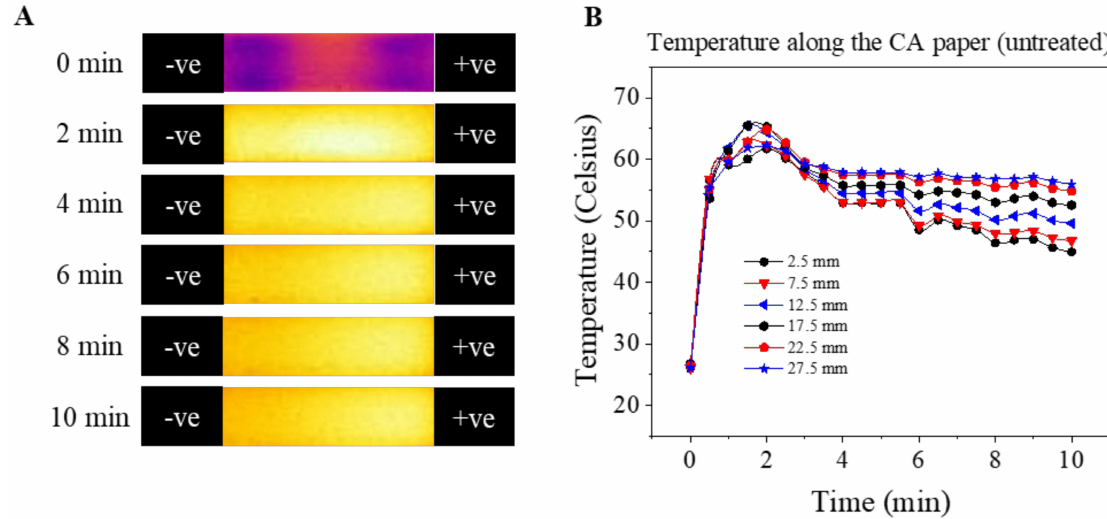
Figure 5. Spatial temperature distribution at 0, 2, 4, 6, 8, and 10 min under electric field. ( A ) Time-lapse infrared images of a CA paper run under 8333 V/m (250 V) electric field. ( B ) Average temperature change with time of the CA paper at 2.5 mm, 7.5 mm, 12.5 mm, 17.5 mm, 22.5 mm, and 27.5 mm from the anode under 8333 V/m (250 V) electric field. Temperature changes up to 40 ◦ C (absolute temperature >65 ◦ C) were reached within 2 min after applying the electric field. The magnitude of the temperature changes ( ∆ T) then reduced to 20 to 30 ◦ C depending on the x-axis position. Overall, higher ∆ T were observed at positions closer to the anode than at positions closer to the cathode side of the CA